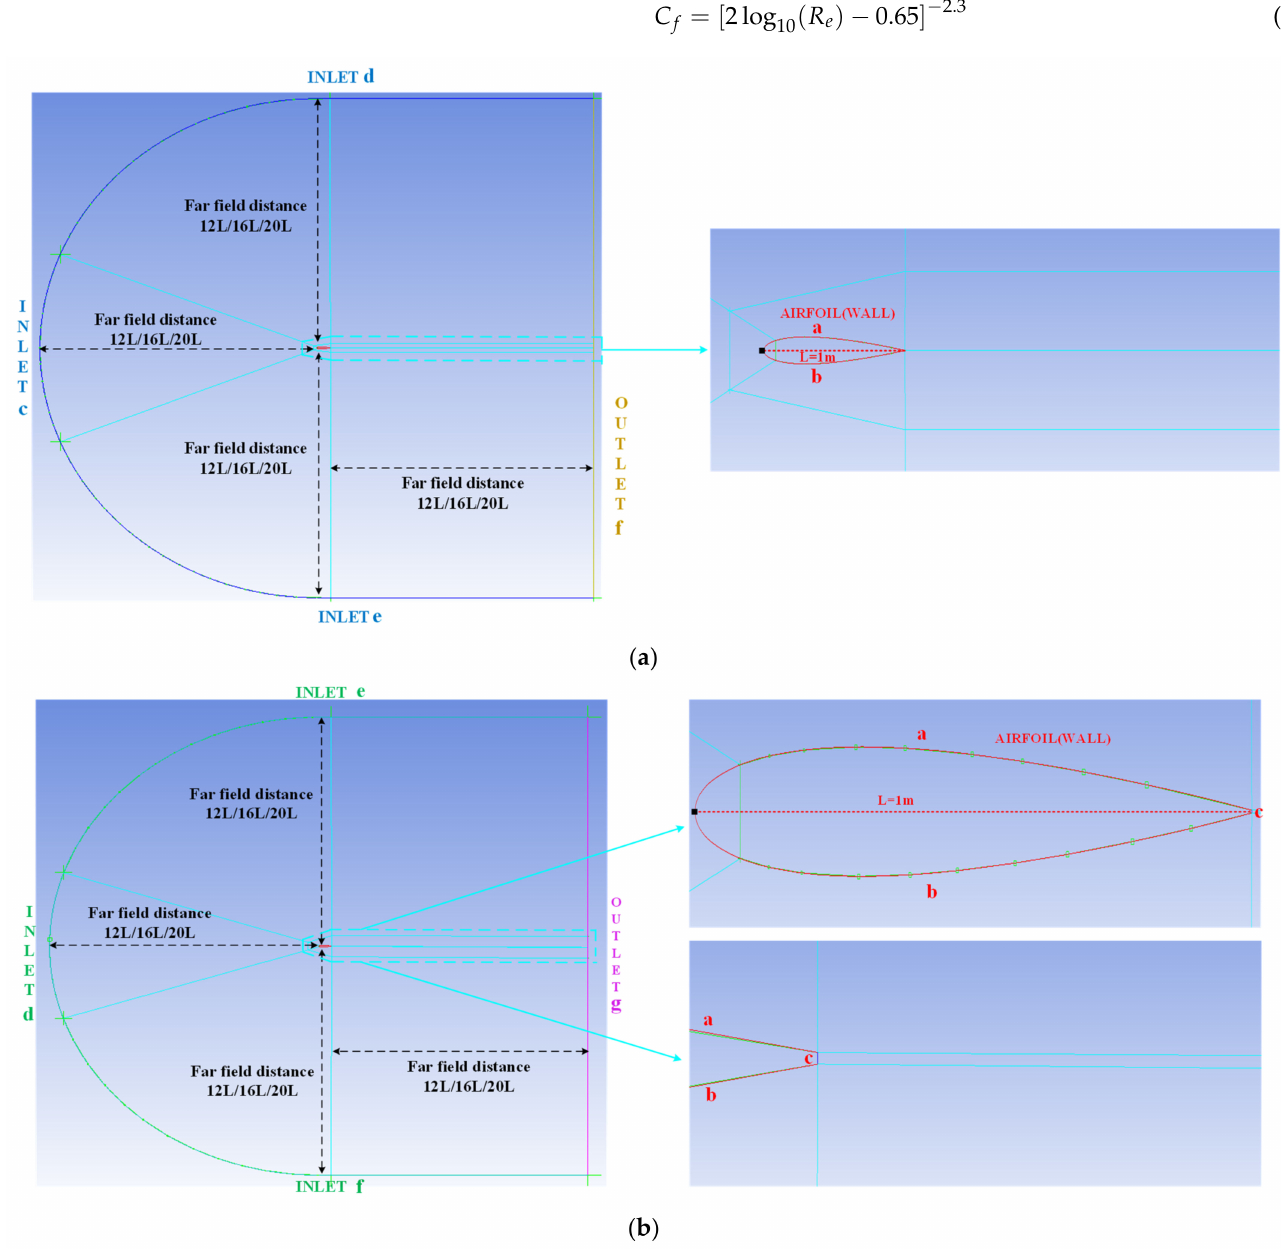
Figure 2. ( a ) Grid division of the sharp trailing edge; ( b ) Grid division of the blunt trailing